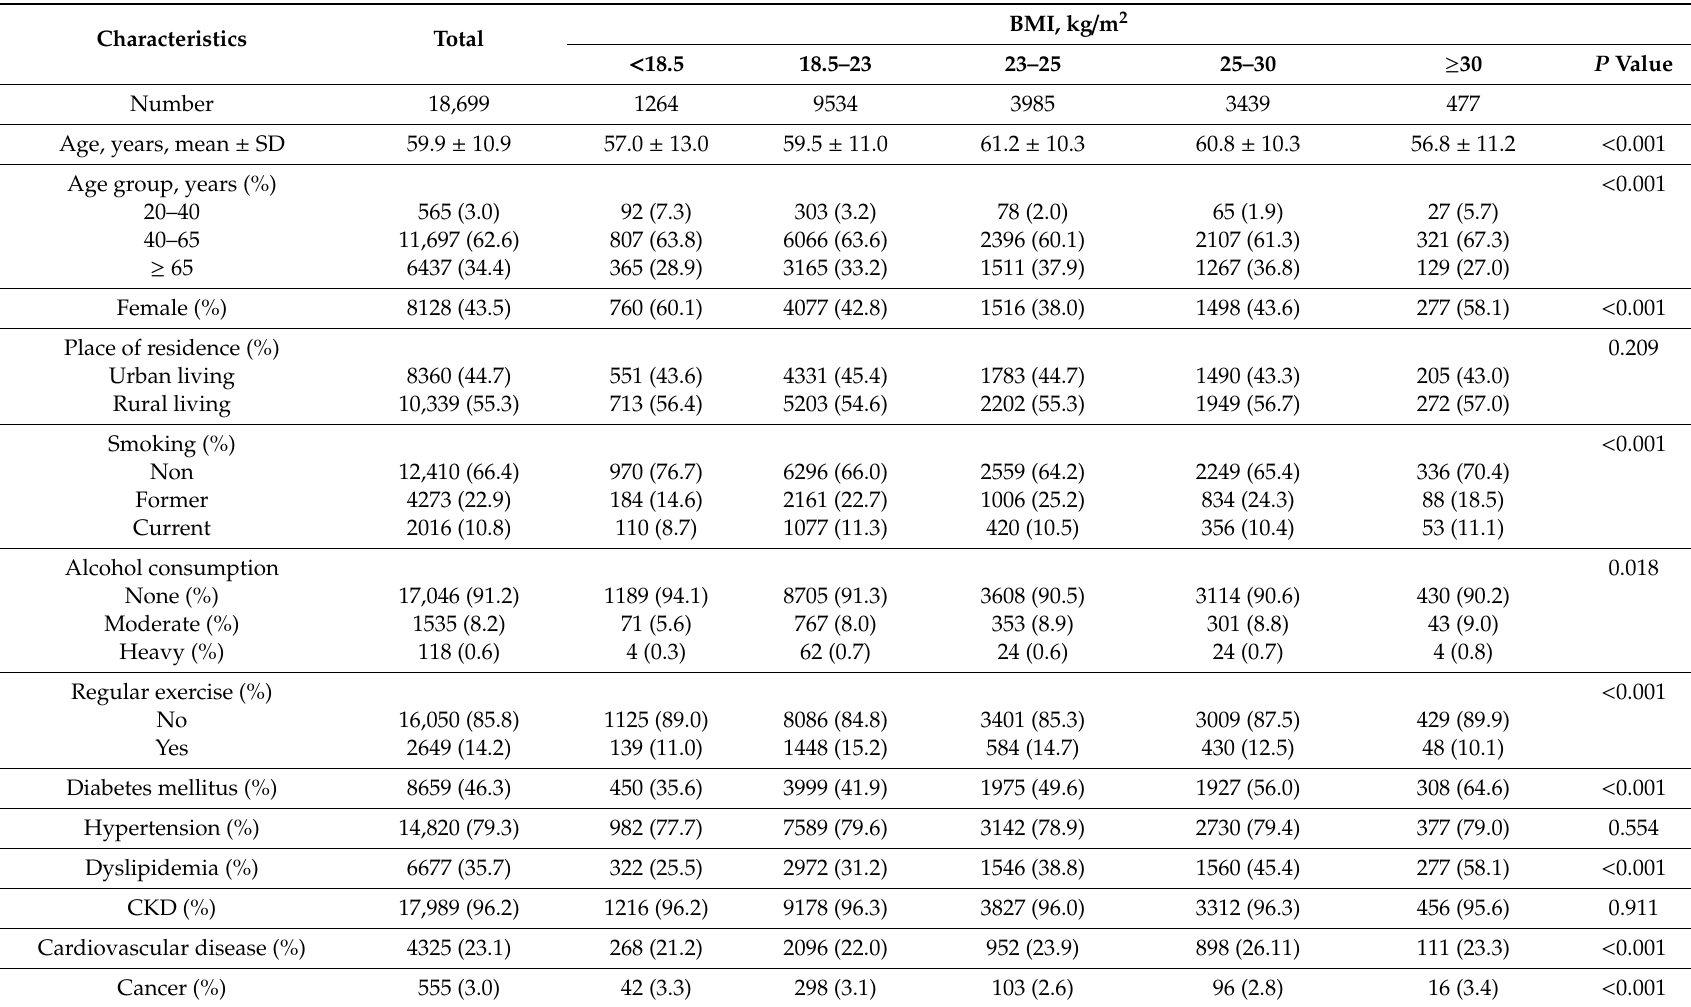
Table 1. Baseline characteristics of the study population by body mass